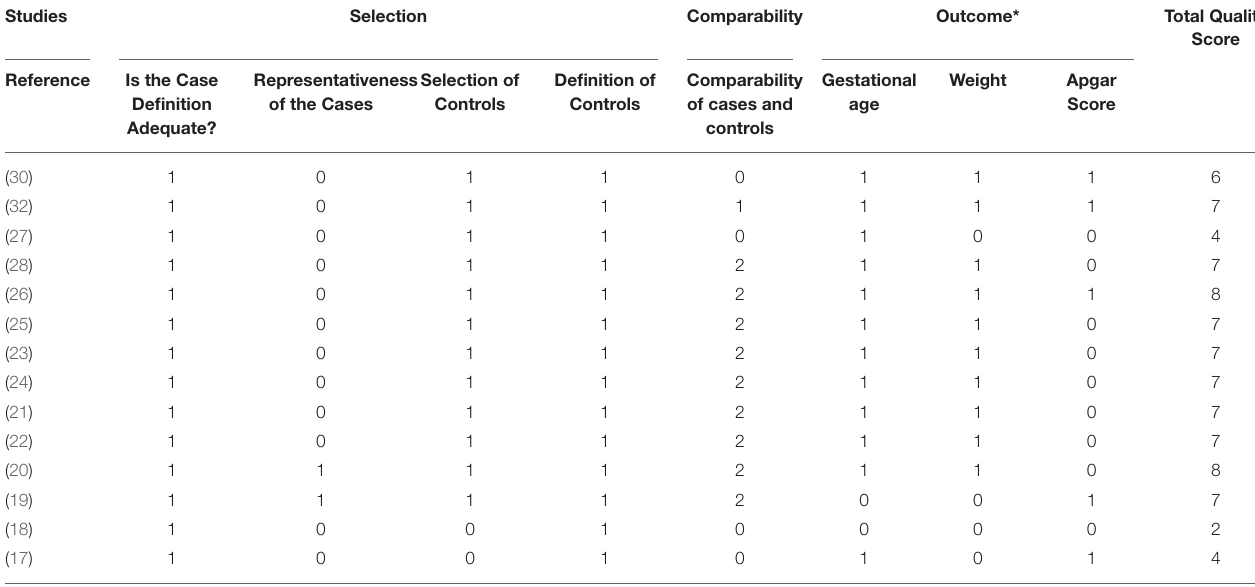
TABLE 2 | Modified Newcastle–Ottawa Scale (NOS) for assessing the quality of studies in meta-analyses.